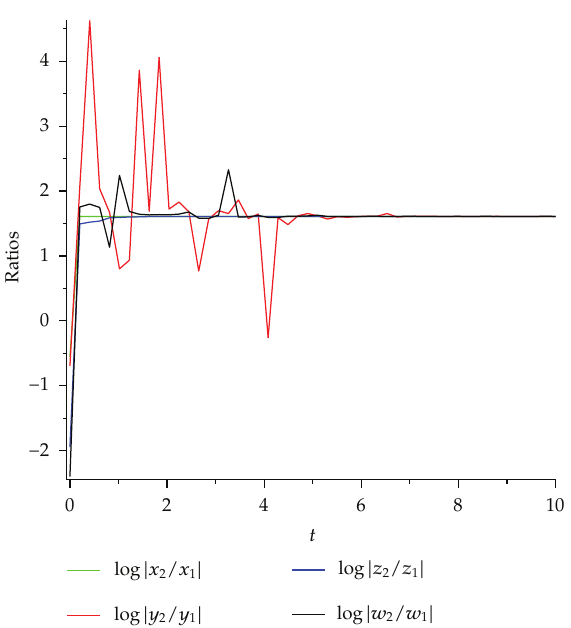
Figure 10: It shows the evaluation of the ratios log | x 2 /x 1 | , log | y 2 /y 1 | , log | z 2 /z 1 | , and log | w 2 /w 1 | whose limits are equal to to log5 (cid:8) 1 . 609.